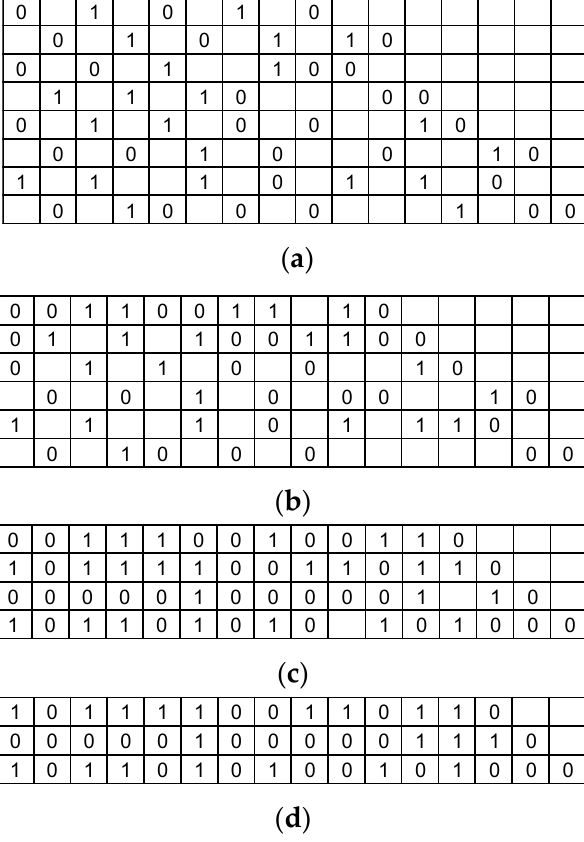
( a ) ( b ) ( c ) ( d ) Figure 10. IEEE 802.11ay parity check matrix with R = ( a ) 1/2, ( b ) 5/8, ( c ) 3/4, and ( d ) 13/16.